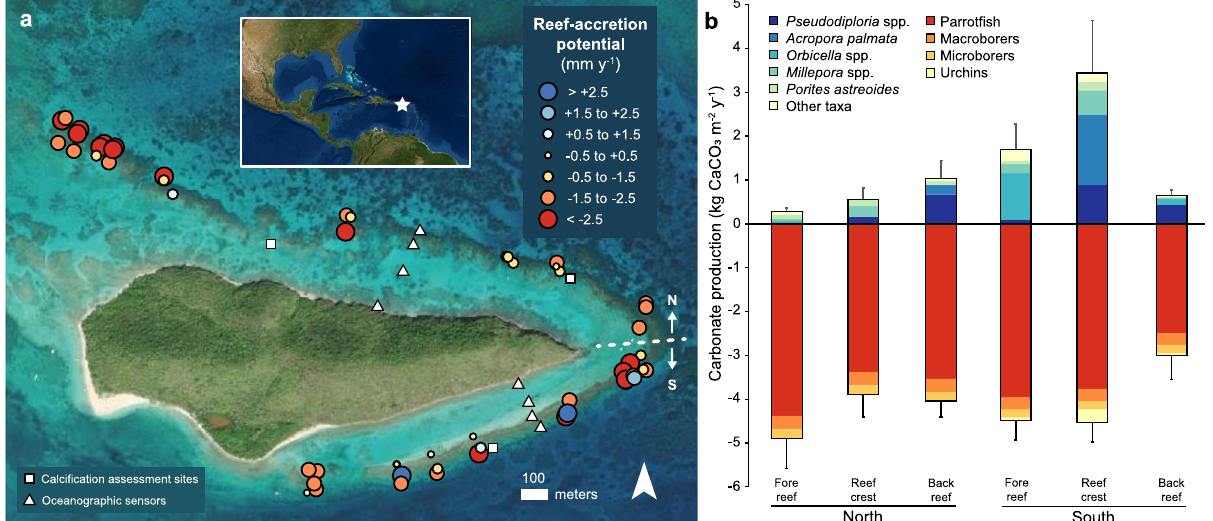
Fig. 1 | Map of the study area and carbonate budgets at Buck Island Reef National Monument in 2016, highlighting the signi fi cantly higher carbonate production and coral reef-accretion potential in the southern reef crest com- pared with the other reef zones. a Estimated mean reef-accretion potential (mmy − 1 ) at 54 sites from the fore-reef, reef-crest, and back-reef habitats around the island. Locations where in situ growth of Acropora palmata and Pseudodi- ploria strigosa were quanti fi ed (white squares) and transects where in situ